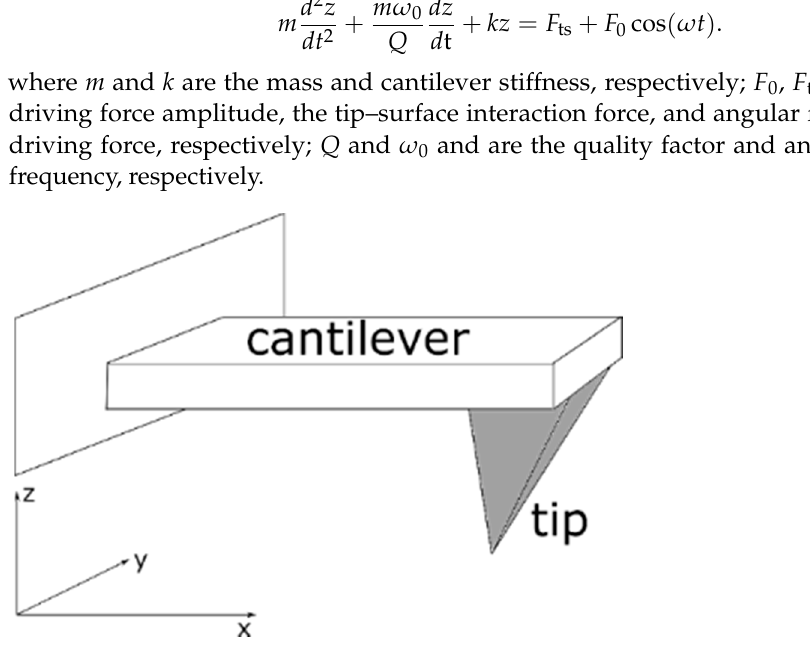
Figure 1. Schematics of the standard MFM microcantilever with tip and the Cartesian coordinate